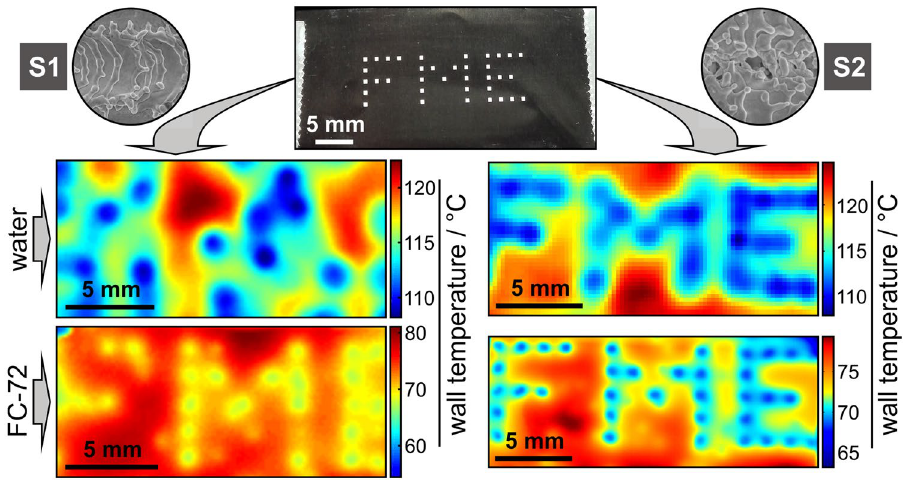
Figure 3. Controlled nucleate boiling performance of water and FC-72. Photography of laser-textured “FME” pattern of S1 (left) and S2 (right) structure is shown on the top. Average temperature fields of boiling surfaces are presented for water at 150 kW m − 2 (top) and FC-72 at 15 kW m − 2